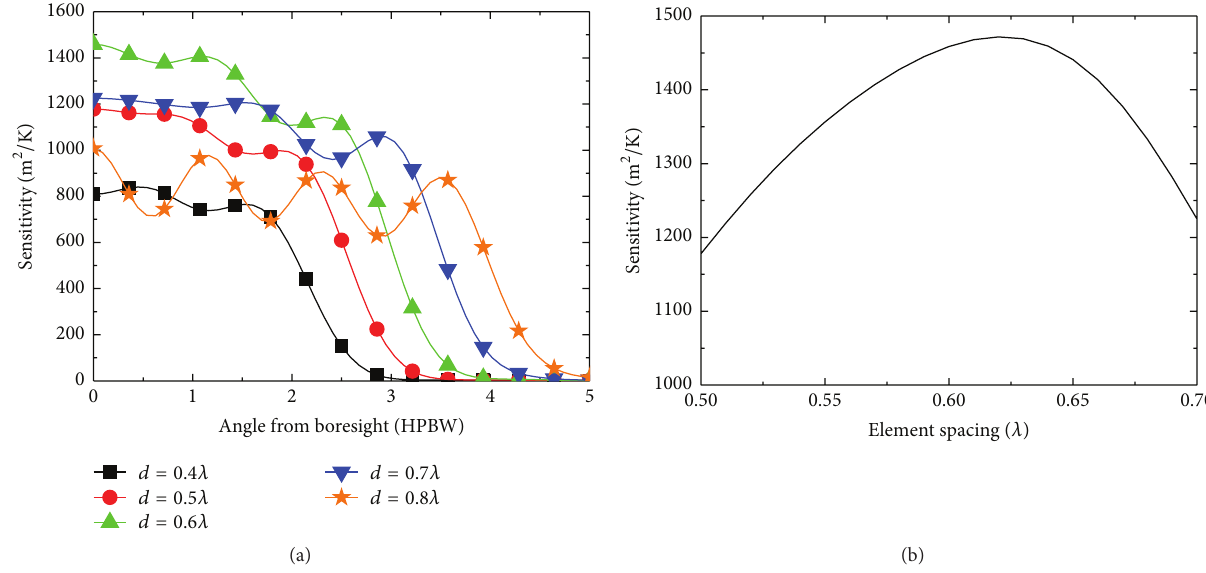
Figure 4: Relationship between sensitivity and element spacing. (a) Sensitivity variation with the increase of spacing. (b) Sensitivity of boresight over different element